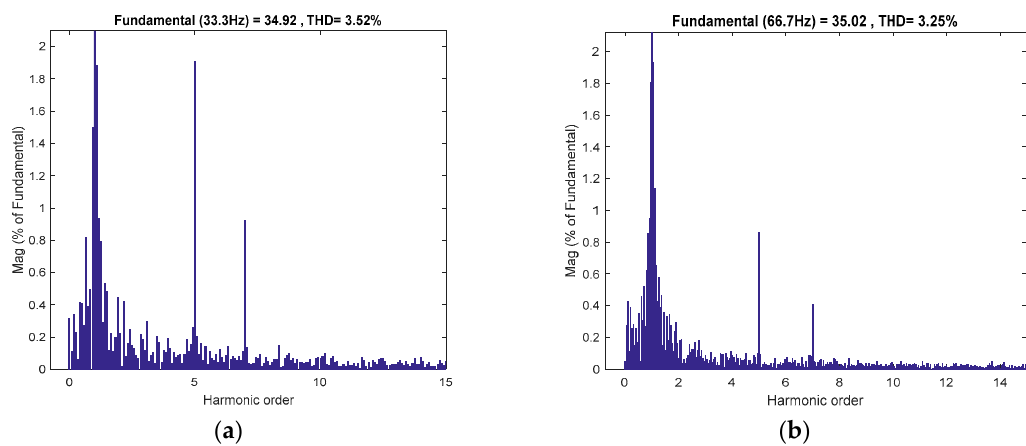
Figure 17. Phase A and D currents after adopting the proposed resonant controller only, ( a ) speed is maintained at 500 rpm, and ( b ) speed is maintained at 1000 rpm.